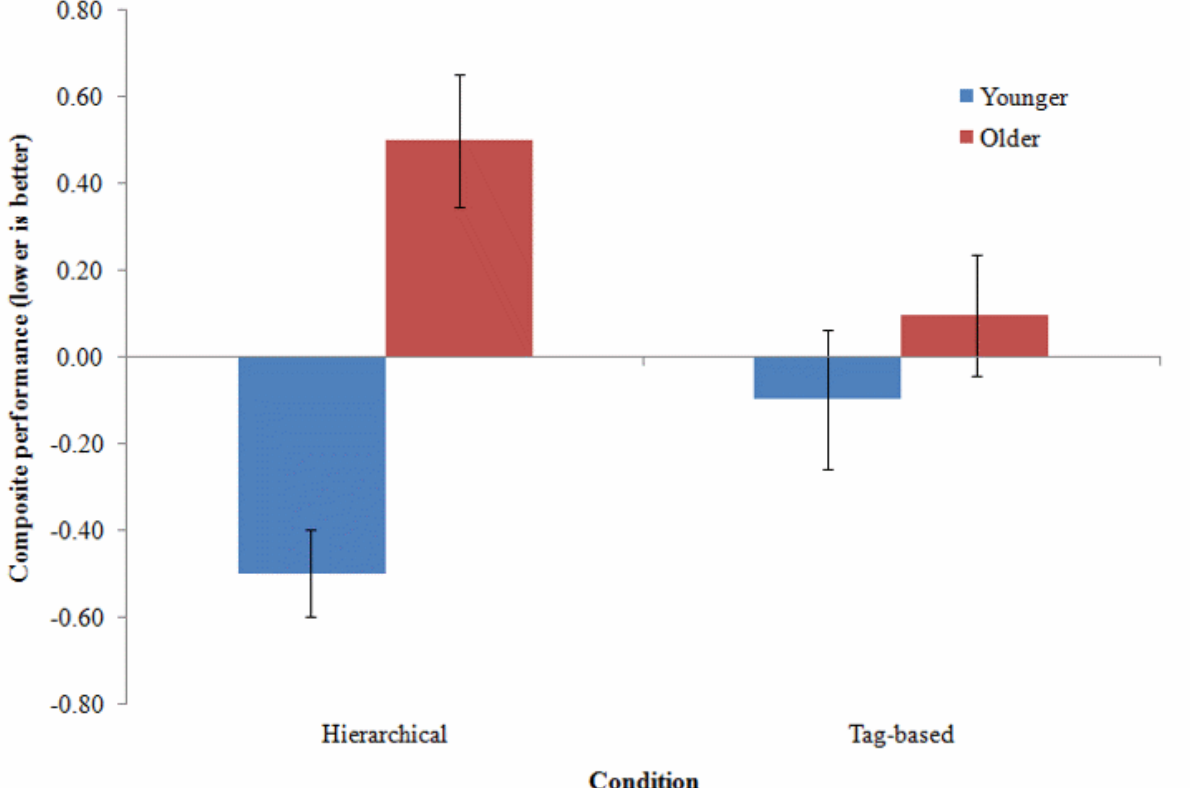
Figure 4. Performance as a function of condition and age group (error bars represent standard